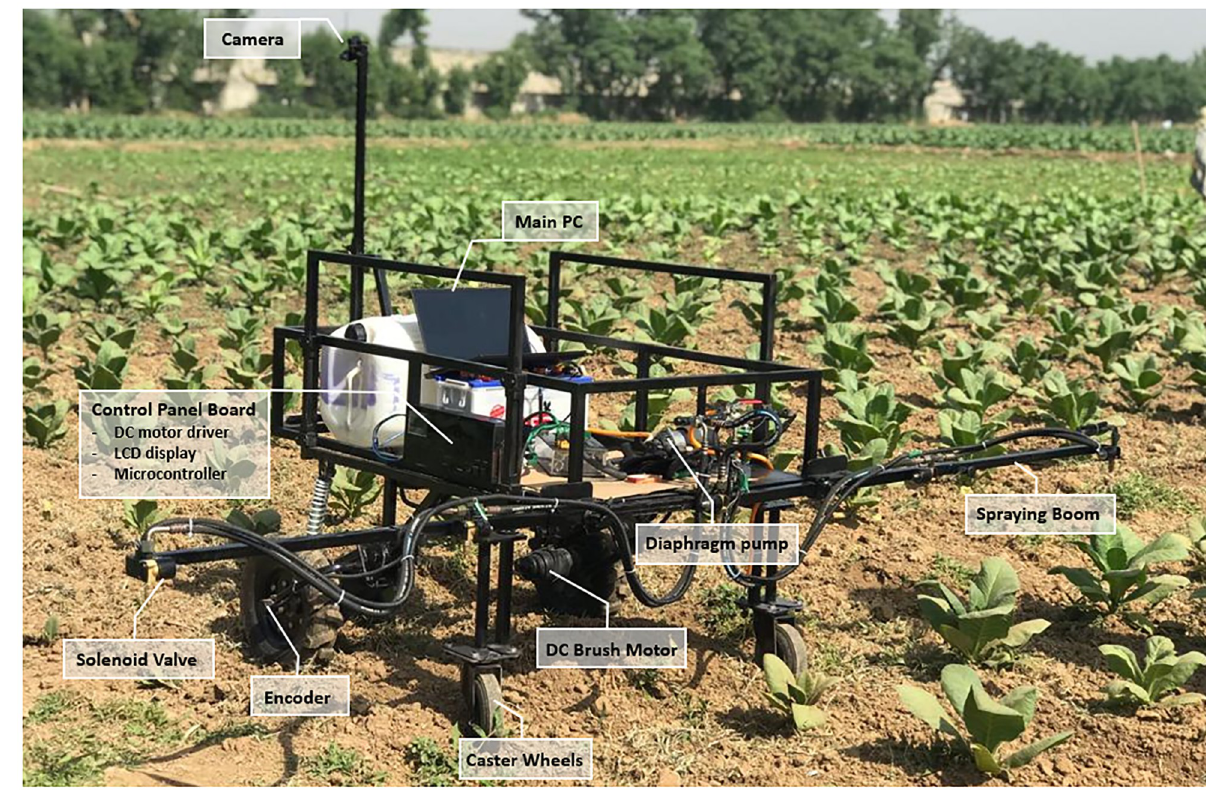
Fig 9. Field testing for selective spraying